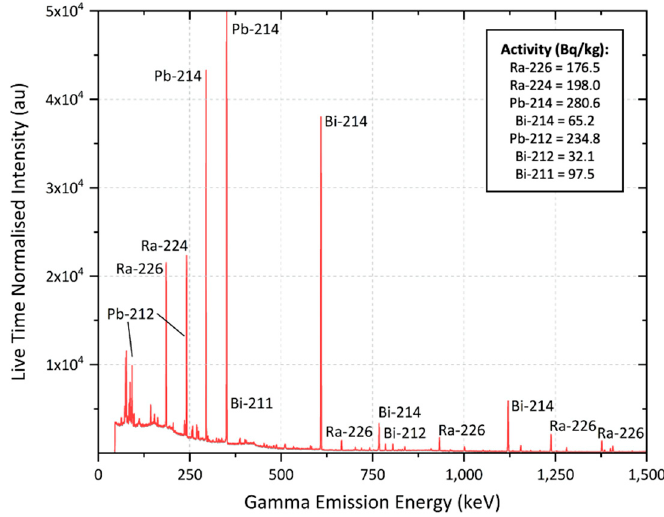
Figure 5. Gamma-ray spectrum (normalised to the system live time) of an ore sample obtained from Wooley Mine, analysed using the laboratory cryogenically cooled HPGe system. Inset; activity contributions (in Bq/kg) of the ingrown daughter species.